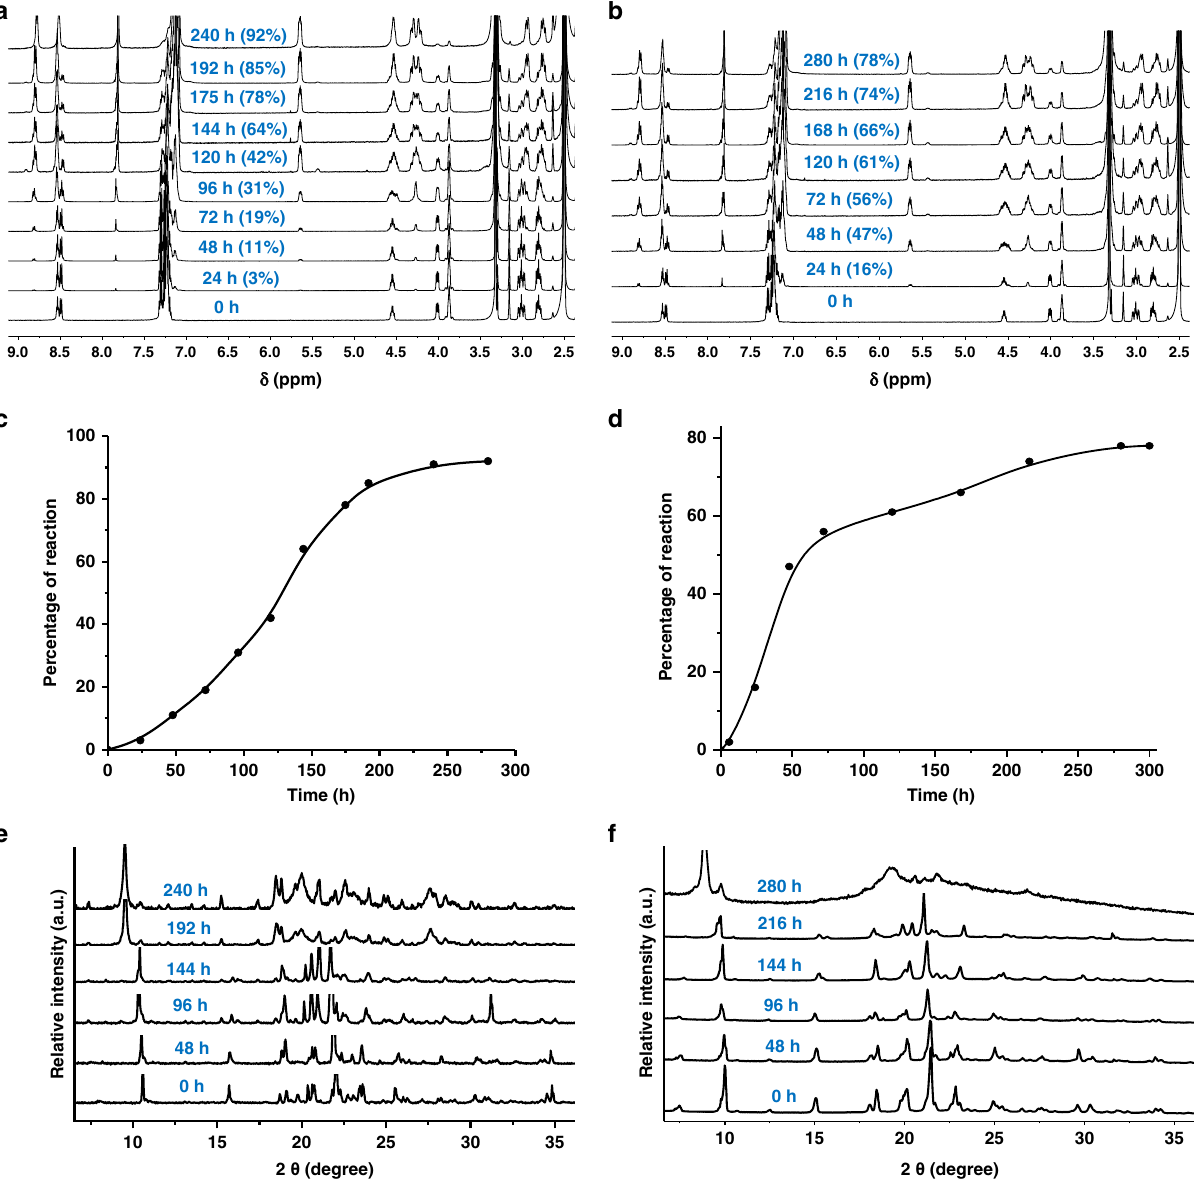
Fig. 3 TAAC reactions of the gel-derived polymorphs. a , b Time-dependent 1 H NMR (DMSO-d 6 ) of DP-II and DP-III, respectively. c , d Kinetics graph of DP-II and DP-III, respectively. e , f Time-dependent PXRD spectra of DP-II and DP-III, respectively. Source data are provided as a Source Data fi le for Fig. 3c –